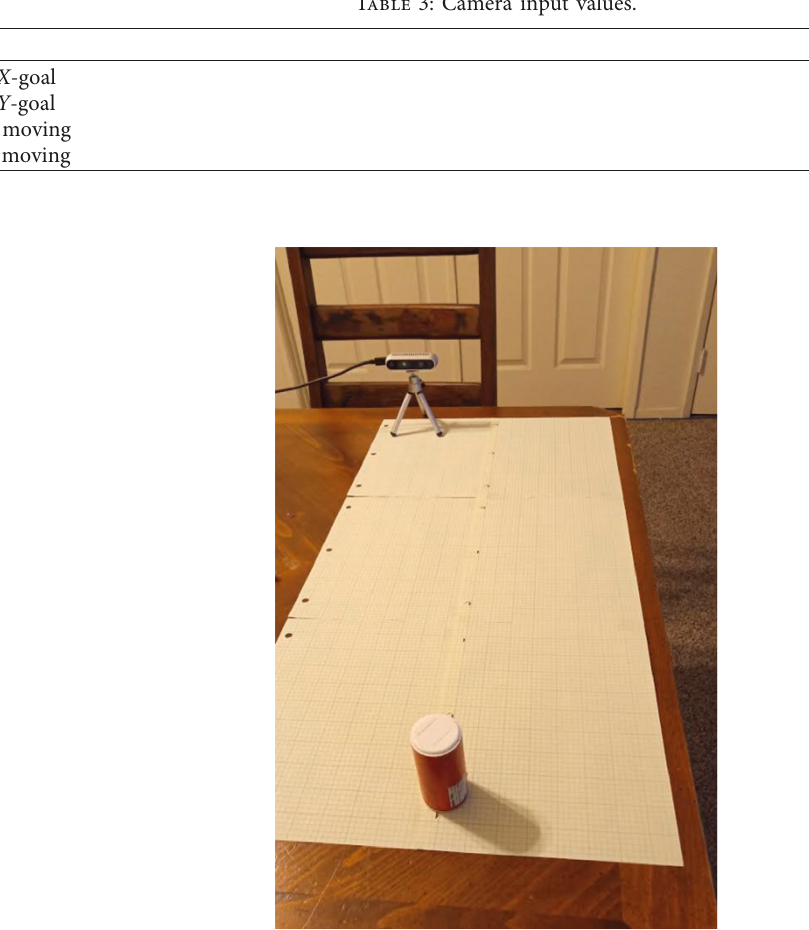
Figure 22: Point selection verification physical